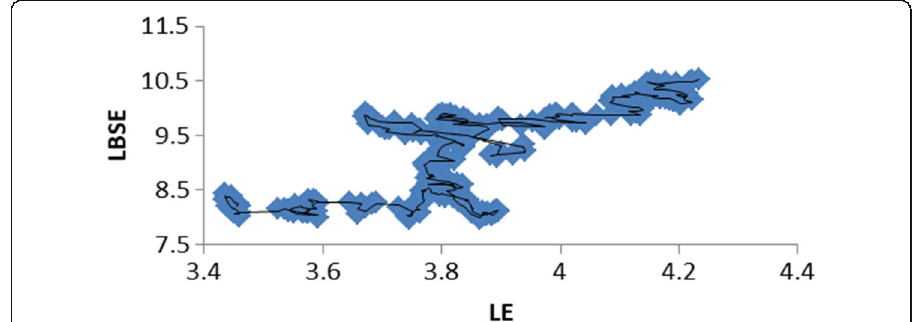
Fig. 4 Scatter Plot of LBSE and LE